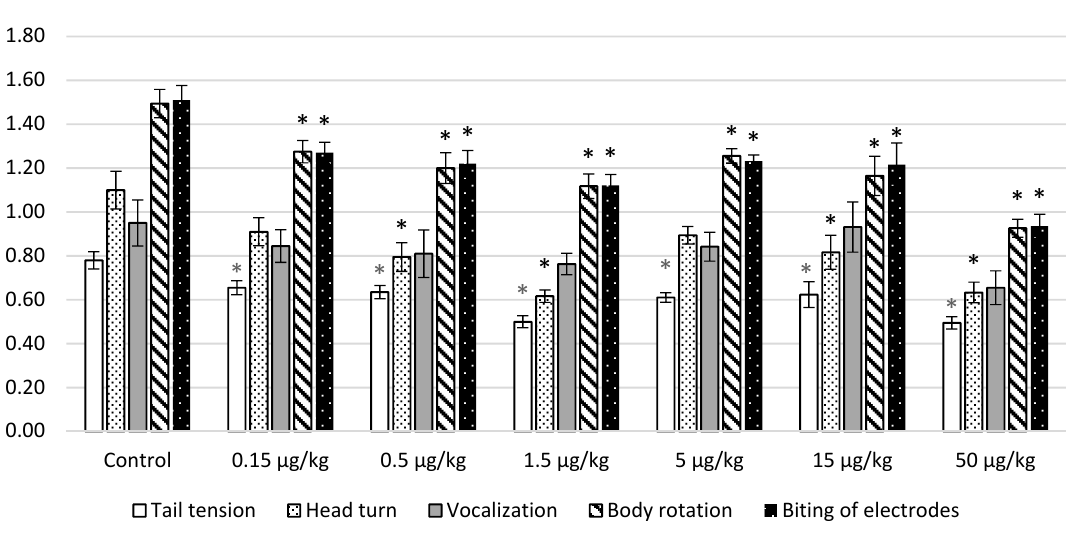
Figure 1. The thresholds (mA, M ± m) of the painful and affective reactions of rats in the tail electric stimulation test after intraperitoneal L-lysine administration. Note: the obtained data were analyzed by ANOVA and the post hoc Dunnett’s test; * – p < 0.05–0.001 in comparison with the control values.